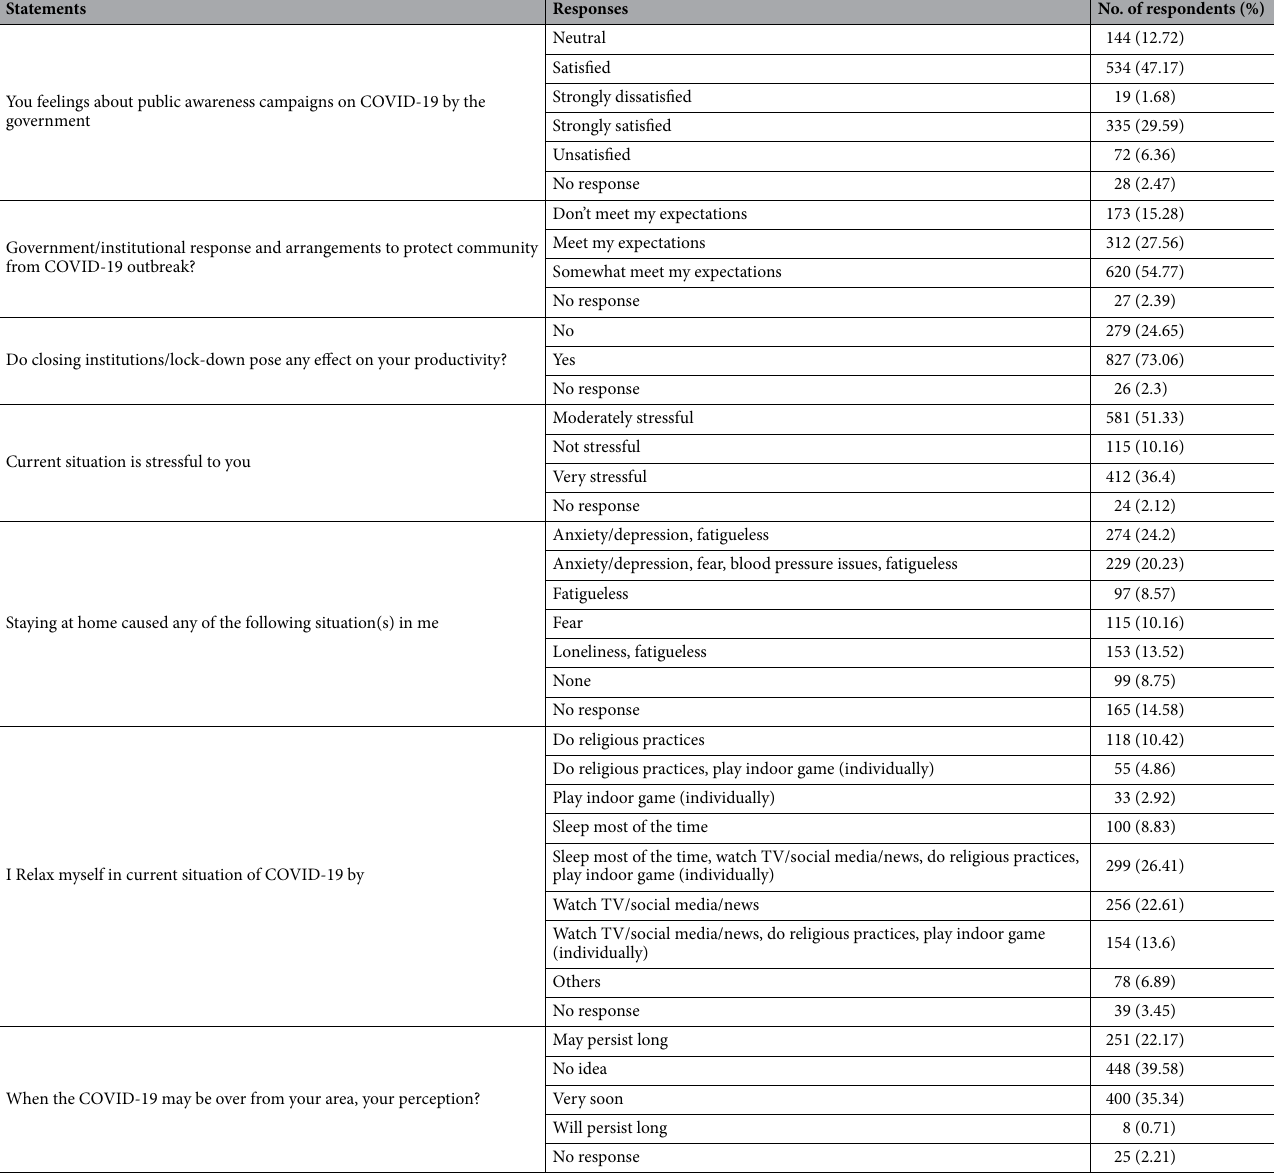
Table 1. Question wise responses and